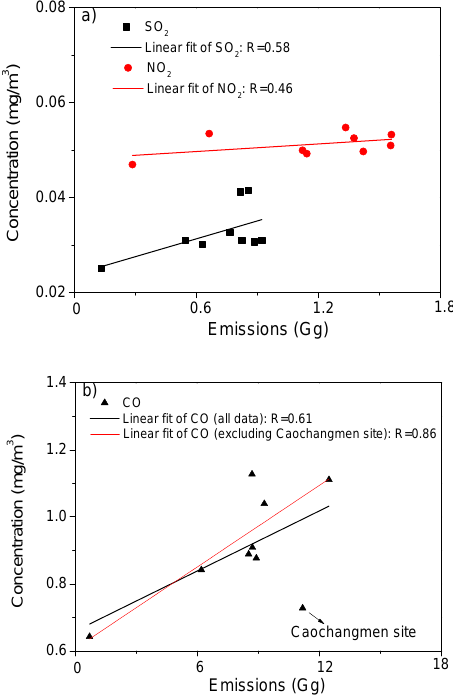
Figure 7. Linear regression of emissions and concentrations at the nine state-operated stations in Nanjing, 2012. (a) SO 2 and NO x / NO 2 ; (b)